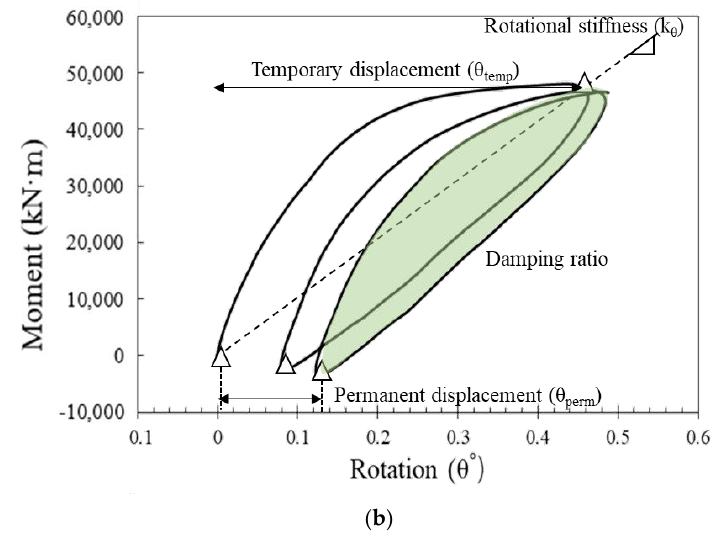
Figure 8. Definitions of the cyclic stiffness and displacements: ( a ) schematic for the rotation behavior of tripod foundation and ( b ) plots of the cyclic characteristics.